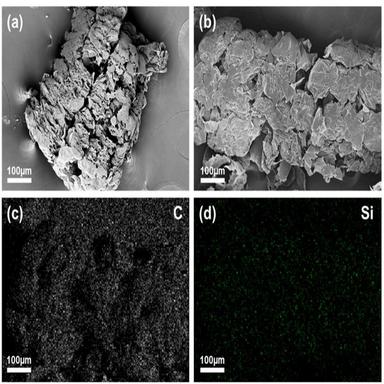
Morphologies of fillers: (a) raw EG, (b) surface of EG-PDMS, and (c,d) EDS mapping of EG–PDMS.